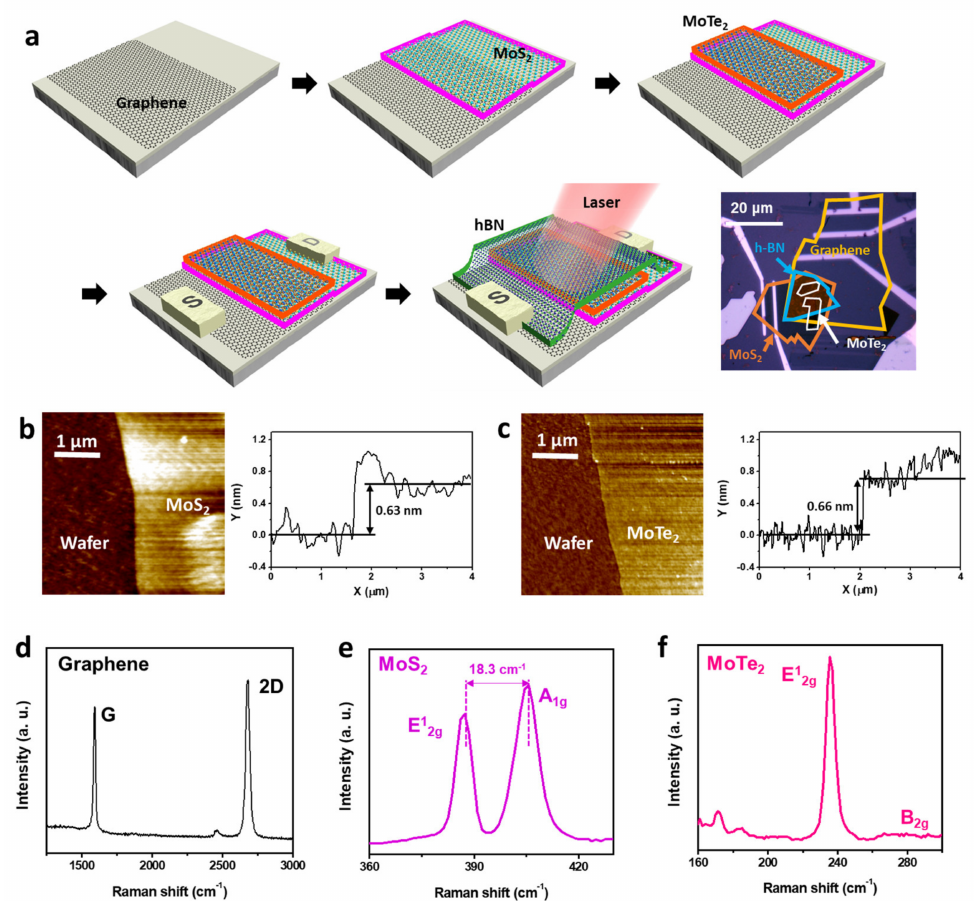
Figure 1. ( a ), Process for fabricating graphene/MoS 2 /MoTe 2 photodetector. ( b ), AFM images ( left ) and corresponding cross − sectional height profiles ( right ) of standalone MoS 2 layer and ( c ), MoTe 2 layer used in photodetector. Raman spectra of ( d ), graphene, ( e ), MoS 2 , and ( f ), MoTe 2